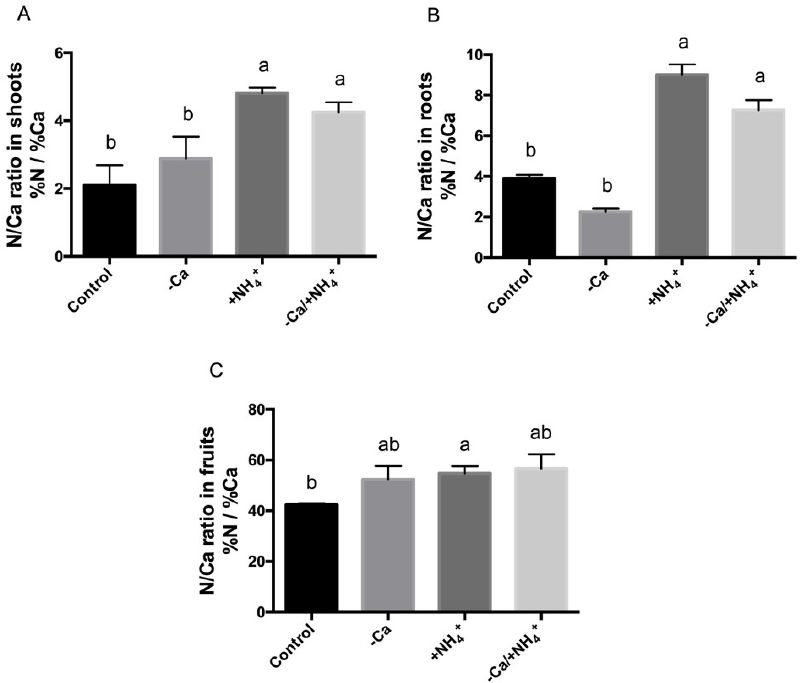
Figure 5. N/Ca ratio was altered in tomato plants with ammonium excess in in-pot experiments. At 132 days after germination, the plants were dissected, and total nitrogen and total calcium were quantified as a percentage of plant dry weight. Nitrogen/calcium ratios were calculated for shoot ( A ), root ( B ), and fruit ( C ) tissue. a, b represents statistically significant differences with p < 0.05. Agronomy 2021 , 11 , x FOR PEER REVIEW